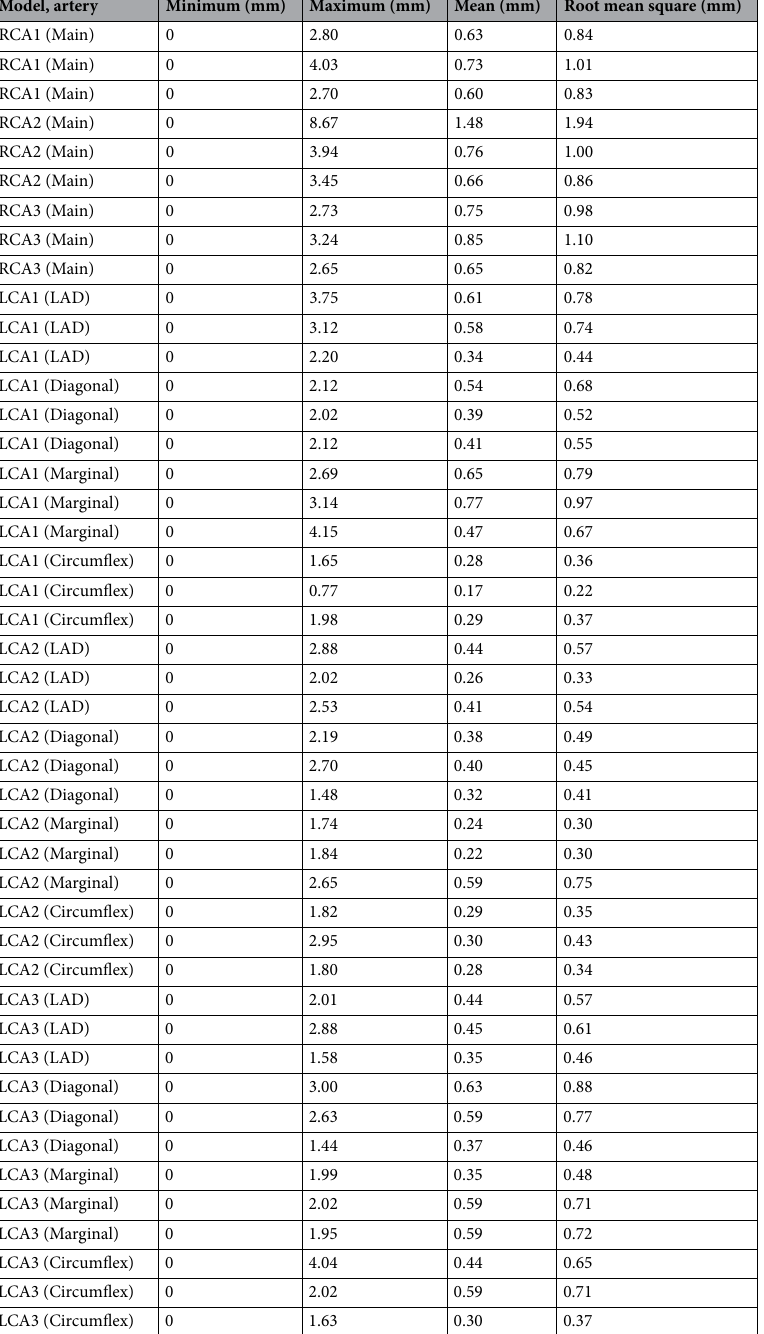
Table 2. Hausdorff distance analysis of surface similarity, presented on a per-vessel basis for all 45 comparisons. Measurements include minimum, maximum and mean distances between sampled points on reference and reconstructed 3D vessels when aligned and superimposed. Root mean square is the most important result, providing an overall value of error in reconstruction of each vessel in